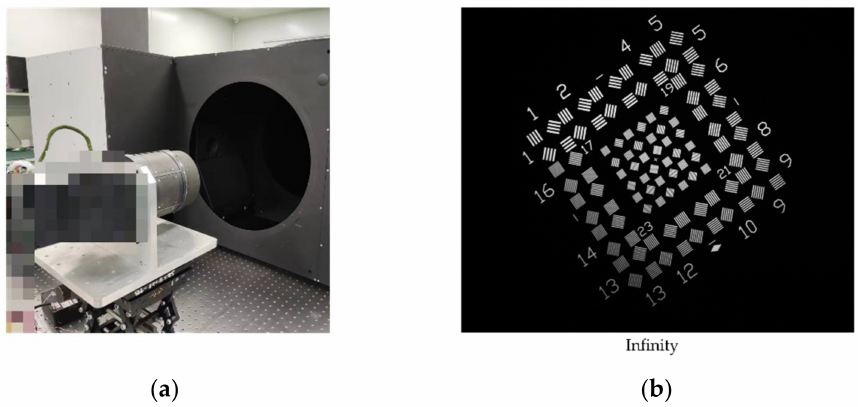
Figure 11. The images of the pixel resolution experiment: ( a ) the real scene; ( b ) the experiment